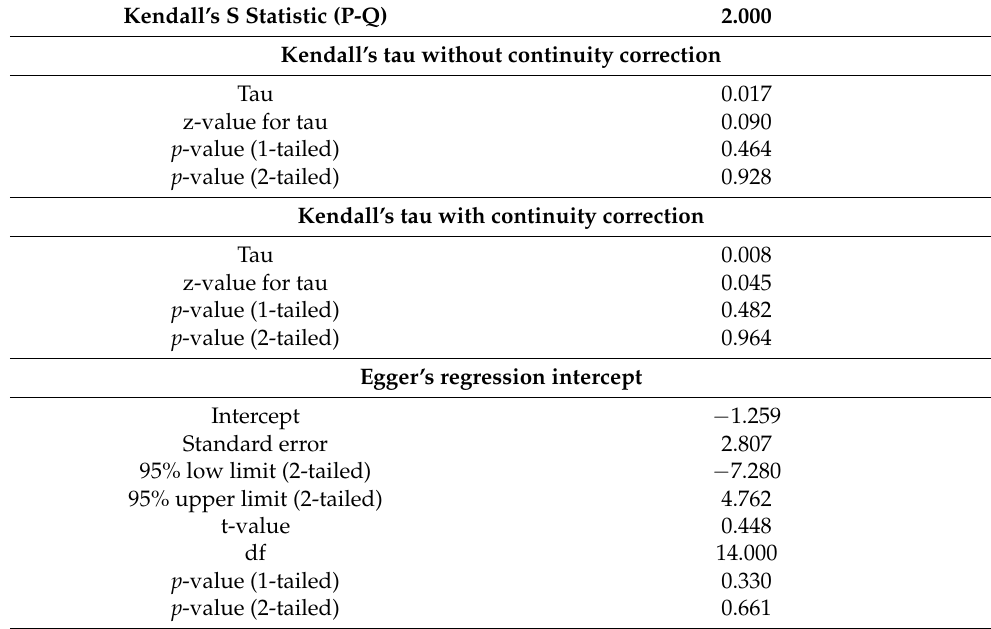
Table 4. Begg and Mazumdar rank correction and Egger’s regression intercept.